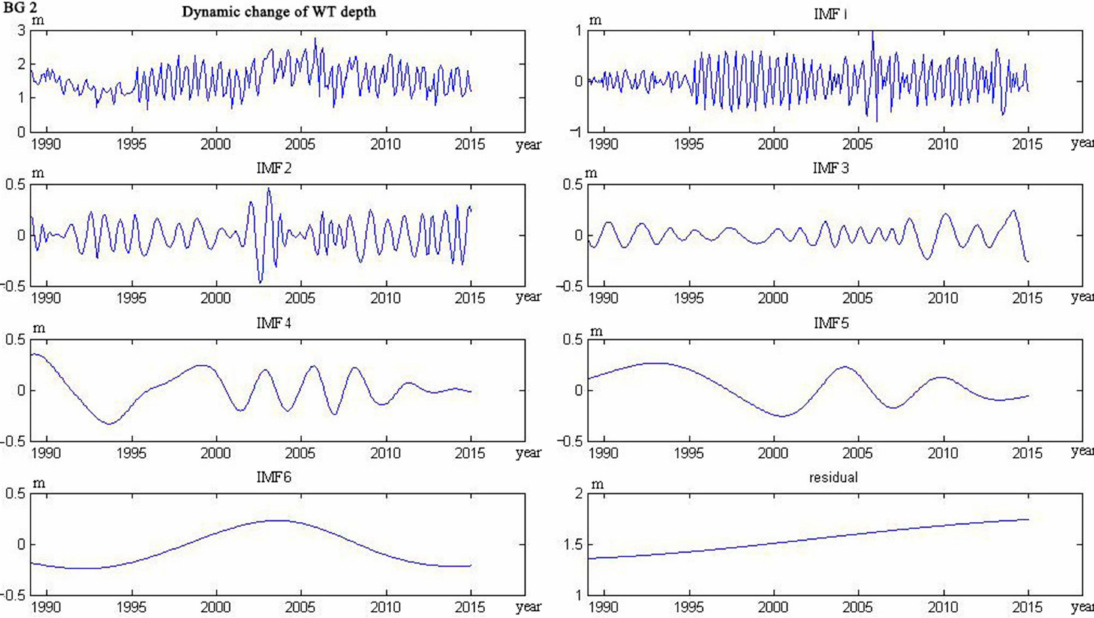
Figure A2. Decomposition of groundwater time series data of well